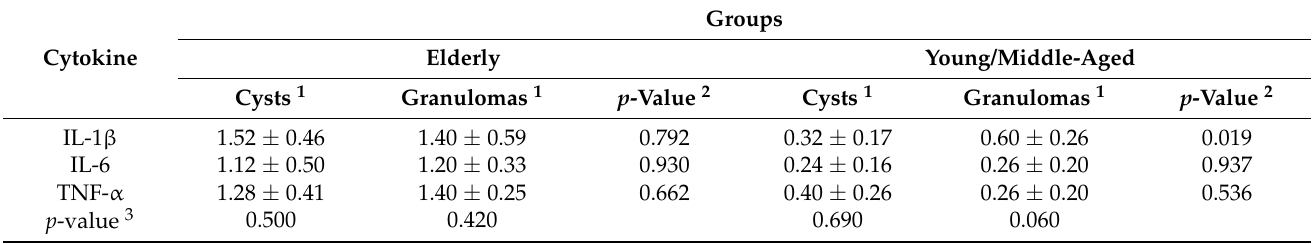
Table 2. Comparative analysis of the expressions of the pro-inflammatory cytokines in granulomas and apical cysts of young/middle-aged and elderly patients.